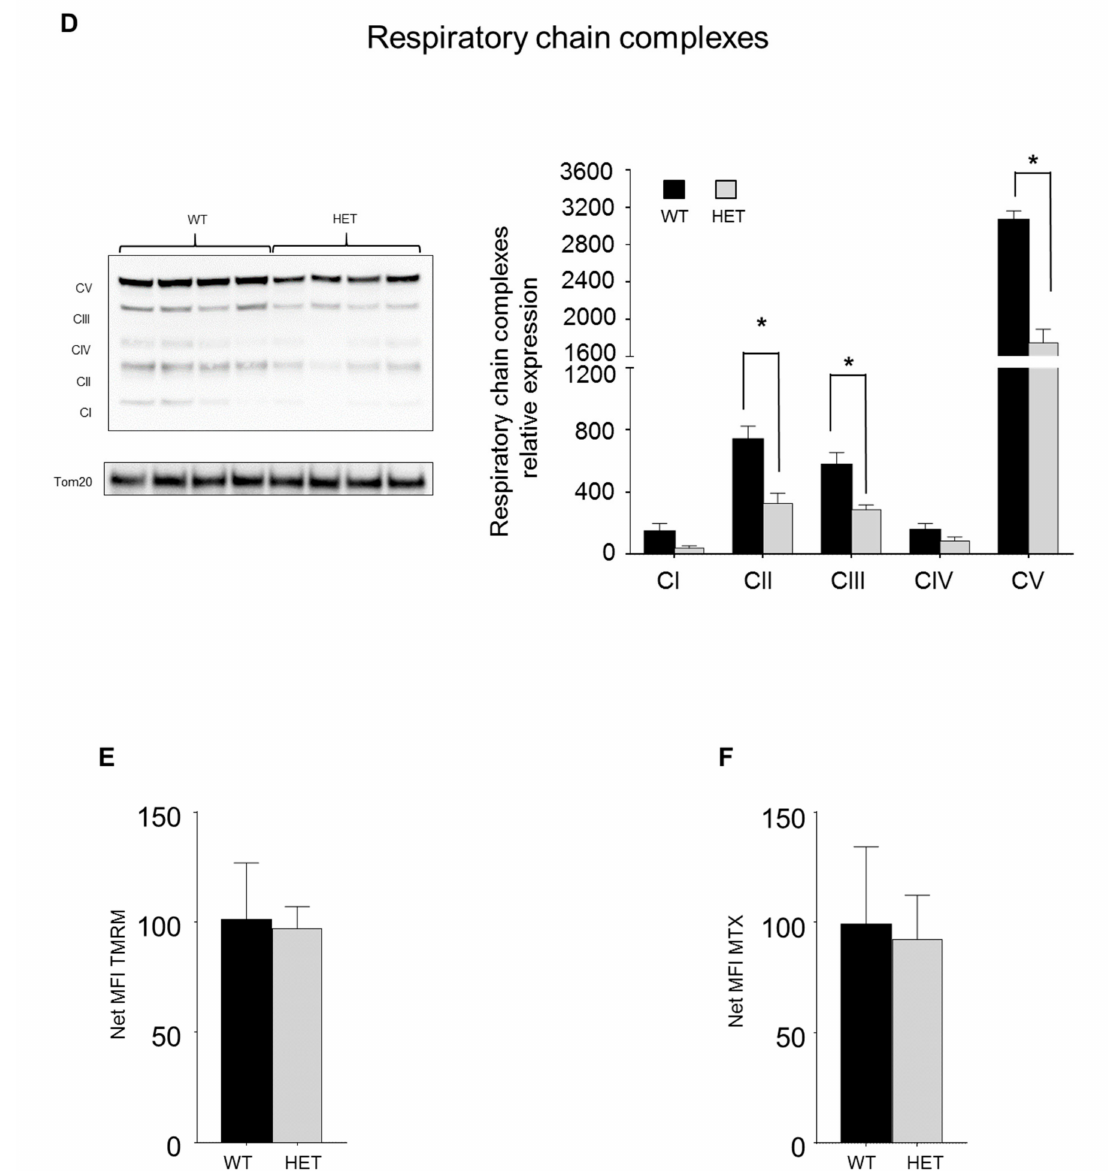
Figure 7. Analysis of mitochondrial functionality in wt and het cells. ( A ) Oxygen consumption rate (OCR) and extracellular acidification rate (ECAR) curves from the analysis of wt (blue and red) and het (green and purple) MEFs, obtained after the sequential addition of the indicated molecules. Data are expressed as mean ± SEM of three independent analyses. ( B ) Parameters of respiration in wt and het MEFs: basal respiration (left panel), maximal respiration, (central panel) and non-mitochondrial oxygen consumption (right panel). Data are expressed as mean ± SEM of three independent experiments. ( C ) Graph depicting OCR vs ECAR of wt and het cells grown in glucose or galactose. Data are expressed as mean ± SEM of three independent experiments. ( D ) Relative expression of mitochondrial respiratory complexes, as determined by western blot. Data are expressed as mean ± SEM of three independent experiments. ( E , F ) Quantification of mitochondrial membrane potential by tetramethyl-rhodamine, methyl ester (TMRM) and of anion superoxide by MTX. The net median fluorescence intensity (MFI) value of a wt sample was set to 100 and other samples were determined as relative MFI levels according to the formula: (het sample net MFI / wt sample net MFI) × 100. n = 3. Data are expressed as mean ± SEM. * = p < 0.05.